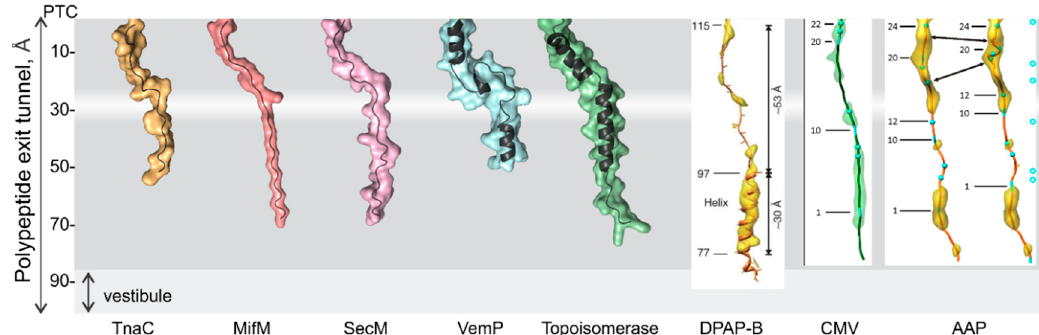
Figure 3. Examples of structures of nascent peptides in the polypeptide exit tunnel. Nascent peptides can interact with the tunnel walls as shown for TnaC [68], MifM [69], SecM [70], and CMV [71], or form α -helices in the upper and lower regions of the tunnel, as illustrated for VemP [62] and DNA topoisomerase peptides [61]. An α -helical structure of dipeptidylaminopeptidase B (DPAP-B) and the AAP peptide in the tunnel are also shown [60,71]. Structures shown on gray background are visualized using the PDB coordinates (PDB ID left to right: 4UY8; 3J9W; 3JBU; 5NWY; 5NP6). The coordinates of structures shown on white background are not available as PDB entries and are reproduced from the respective journals, with